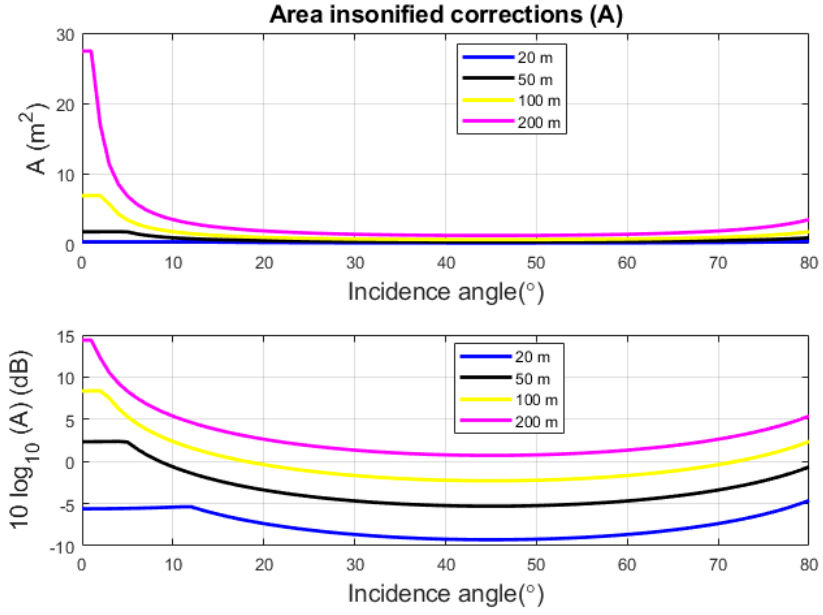
Figure 5. Approximated insonified area corrections in m (cid:2870) and dB re. 1 m² at depths varying from 20 to 200 m, with a flat sea floor, pulse length of 150 𝜇𝑠 , and along-track/across-track beamwidths of 1.5°.